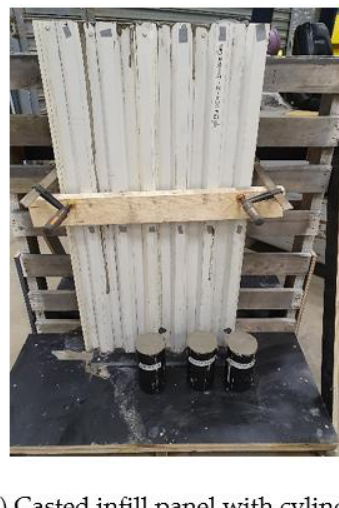
Figure 3. Casting of panels.